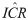
Empirical Integrated Continuous Return ICR fitted to the forecasting model ICR^ (Eq (2)).For illustration purposes, we use DBSM.SI and a tStart of 15 Dec 2006. tEnd is then slowly increased with an interval of two weeks. The upper half of each sub-figure shows the empirical ICR (blue) and the fitted ICR^ (red dashed-curve), and the rescaled stock price is shown as the background (black). In addition, the black vertical dashed line represents the tEnd and red vertical line indicates the corresponding tc. The lower half shows the plot of tc(tEnd) as a function of tEnd, where the Lehman Brothers Bankruptcy (15 Sept 2008) is represented by a blue horizontal dashed line and 27 October 2008 is represented by a black horizontal dashed line.